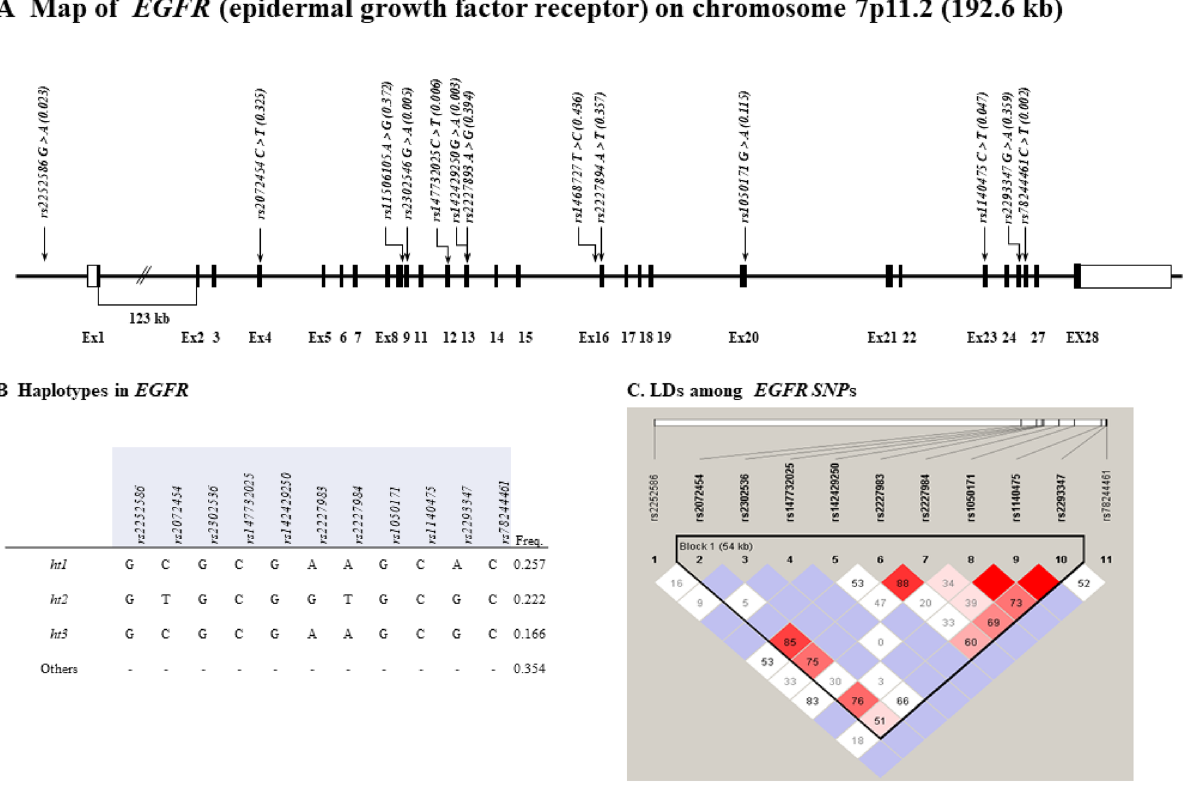
Figure 1. Physical map, haplotypes, and LDs of EGFR (epidermal growth factor receptor). ( A ) Physical map of EGFR and its SNPs genotyped in this study. Black blocks indicate coding exons; white blocks indicate 5’-untranslated region (UTR) and 3’-UTR. Score in the bracket indicates the minor allele frequency (MAF) of SNP. ( B ) Haplotypes of EGFR . Only common haplotypes with frequency over 0.05 are analyzed for association analyses. ( C ) LD plot of EGFR . SNPs investigated in this study compose one LD block. Number in block represents the value of LD coefficient │ D ’ │ .